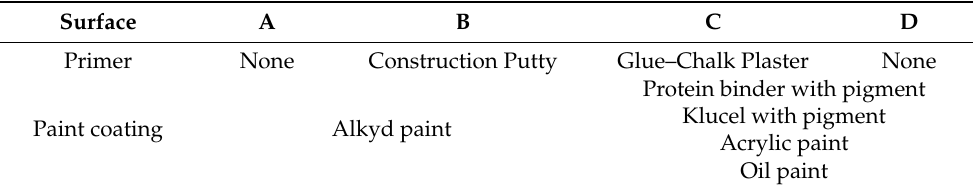
Figure 2. Test element with applied paints: ( a ) front view and ( b ) back view. Table 1. Primers and paints coating corresponding to the surface area used in the experimental programme.